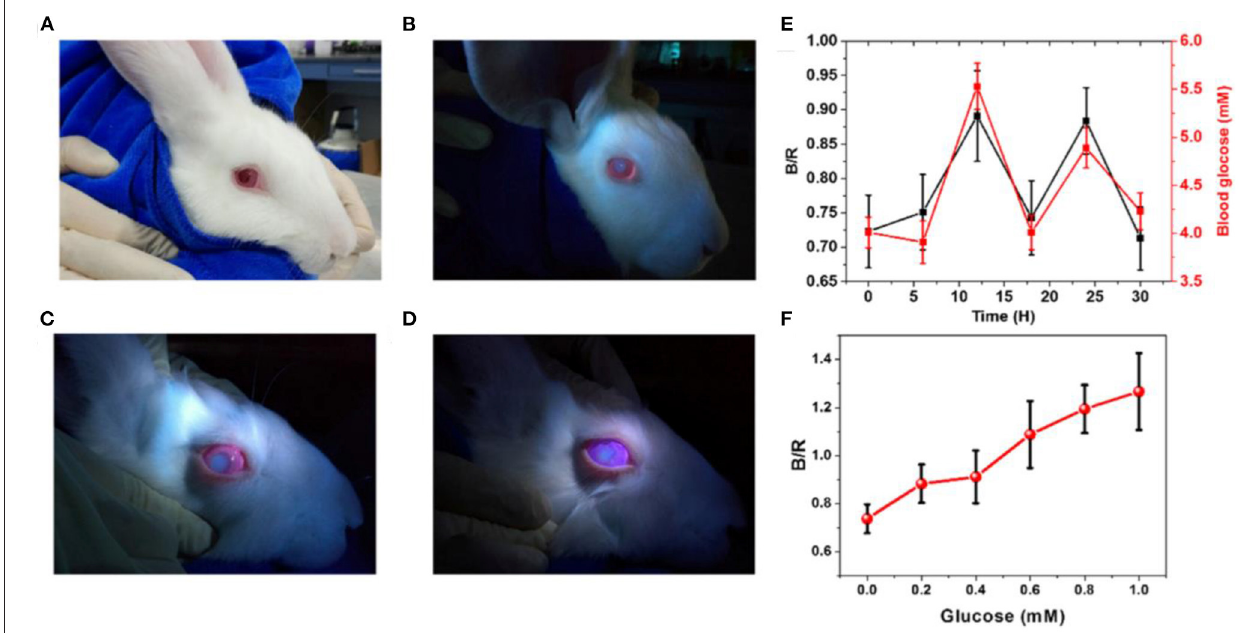
FIGURE 2 | Florescence-based smart contact lens for tear glucose sensing. (A) Photographs of the rabbit wearing the smart contact lens under ambient light illumination. (B) The rabbit eye wearing contact lens under illumination by UV LED light. (C) The worn lens in artificial tears containing glucose of 1mM concentration. (D) The worn lens in artificial tears containing glucose of 5mM concentration. (E) Blood glucose levels measured by a commercial glucose meter over time and their corresponding tear glucose levels measured by analyzing the fluorescent signals emitted from the contact lens worn on the rabbit eye. (F) The ratio of the blue and red channel (B/R) for the images taken for the contact lens worn in the rabbit eye and immersed in artificial tears with different glucose concentrations (